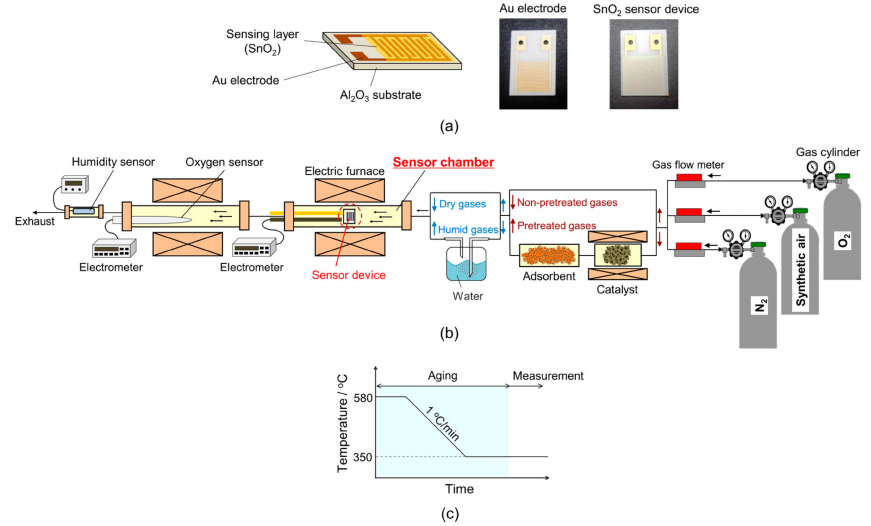
Figure 1. ( a ) Schematic image and photographs of the Al 2 O 3 substrate printed with Au electrode and SnO 2 sensor device. ( b ) Schematic drawing of the measurement apparatus and sensor device for gas sensors. ( c ) Temperature profile of the aging